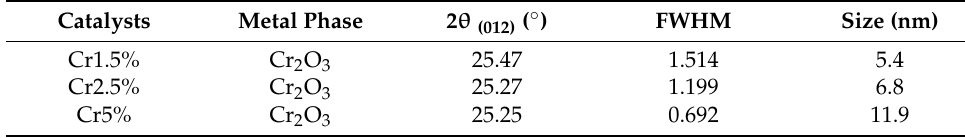
Table 3. Crystallite phases, sizes of Cr 2 O 3 in CrO x / γ -Al 2 O 3